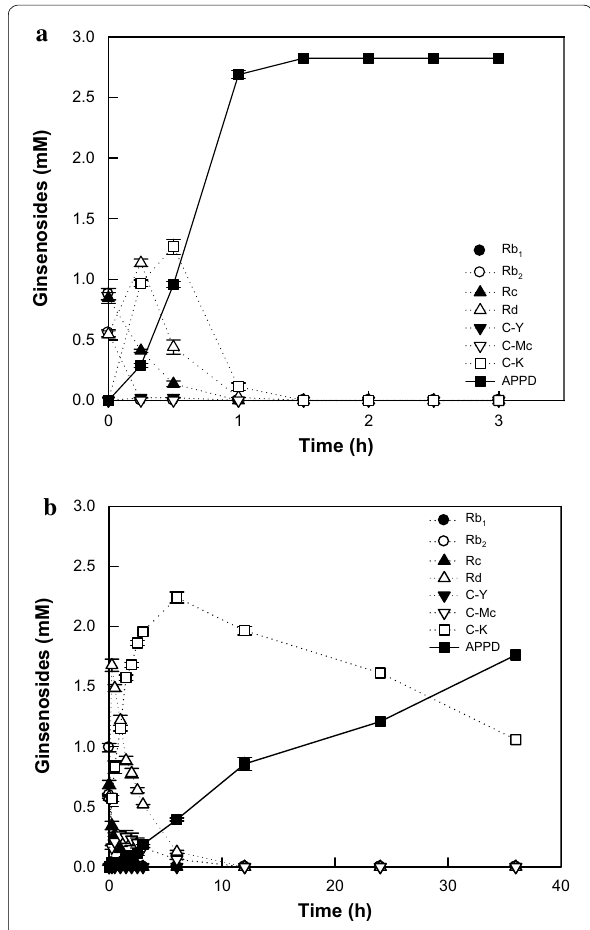
Fig. 3 Time‑course reaction for the production of APPD from PPD‑ type ginsenosides in ginseng root extract by a DT‑bgl supplemented with CB‑bgl and b PF‑bgl. Data represent the means of three experi‑ ments and error bars represent the standard